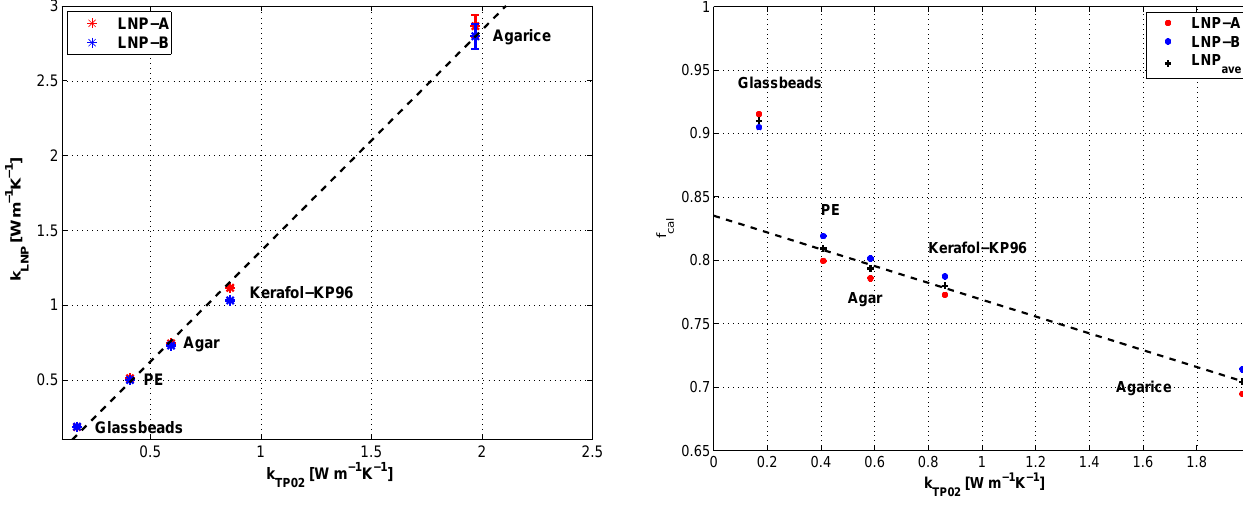
Fig. 6. Plot of the calibration factors for the different materials as Fig.6. PlotofthecalibrationfactorsforthedifferentmaterialsaslistedinTable2. Thedashedlineisalinearfitthroughthemeasurement valuesexcludingtheglassbeads. LNP ave theaverageofthemeasuredLNP-AandLNP-Bvaluesforeachcalibrationmaterial. listed in Table 2. The dashed line is a linear fit through the measure- ment values excluding the glass beads. LNP ave is the average of the measured LNP-A and LNP-B values for each calibration